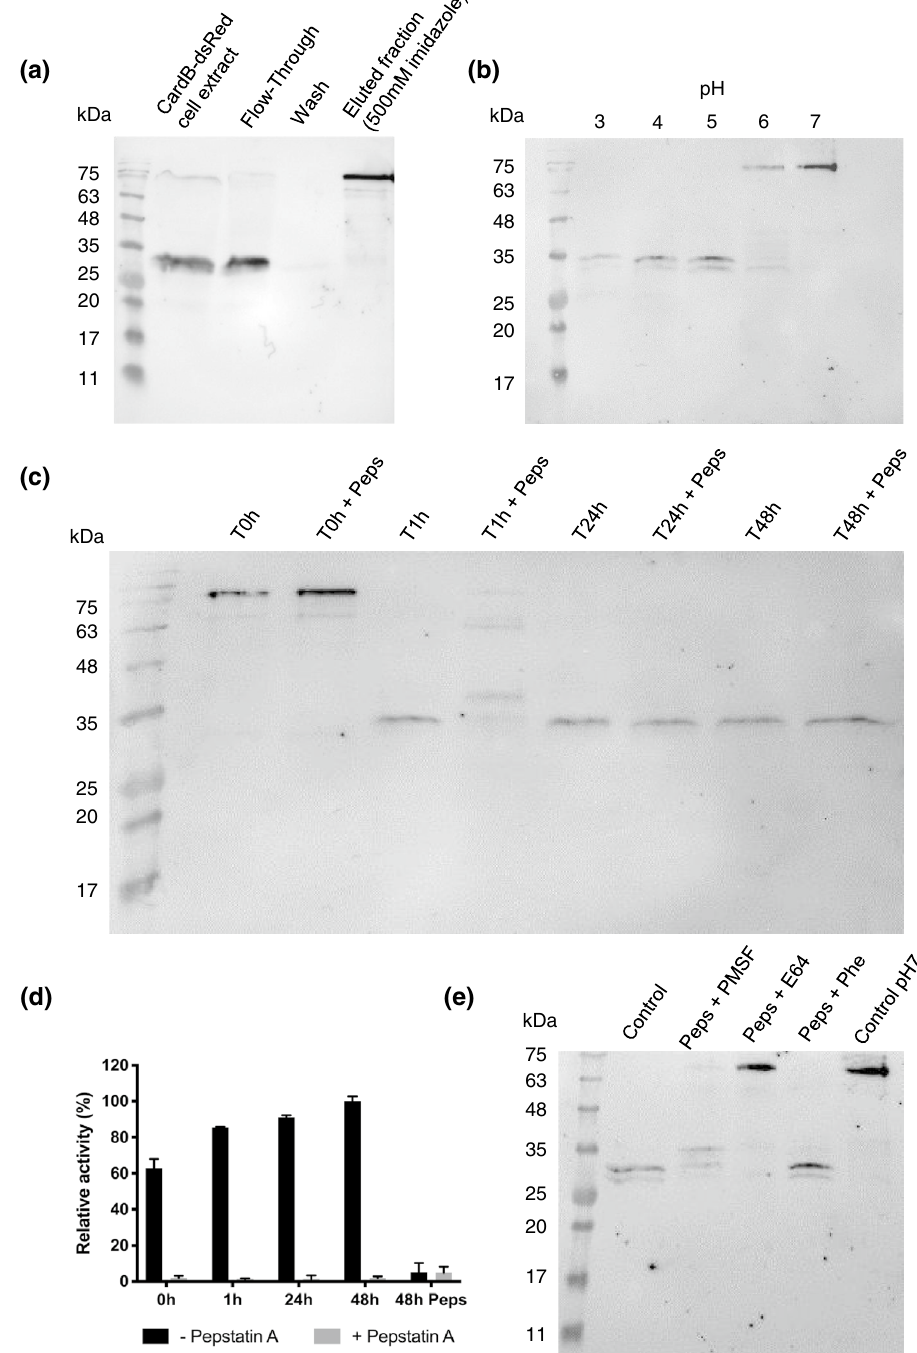
Figure 5. CardB-dsRed fractionation by IMAC and activation assays of unprocessed cardosin B ( a ) Western blot analysis of the fractionation of cardB-dsRed cell extract by IMAC with anti-cardosin B antibody ( b ) Western blot analysis of the effect of pH on unprocessed cardosin B ( c ) Western blot analysis of the effect of pepstatin A on cardosin B at pH 4. Time-points of samples without and with pepstatin A were collected at 0 h, 1 h, 24 h and 48 h after incubation at pH 4 ( d ) Activity assay of samples without and with pepstatin A, the bars 48 h Peps refers to both samples (without and with pepstatin A) treated with Pepstatin A ( e ) Western blot analysis of the combined effect of pepstatin A with other protease inhibitors on cardosin B processing. FT, Flow- Through; Peps, pepstatin A; PMSF, phenylmethylsulfonyl fluoride; Phe,